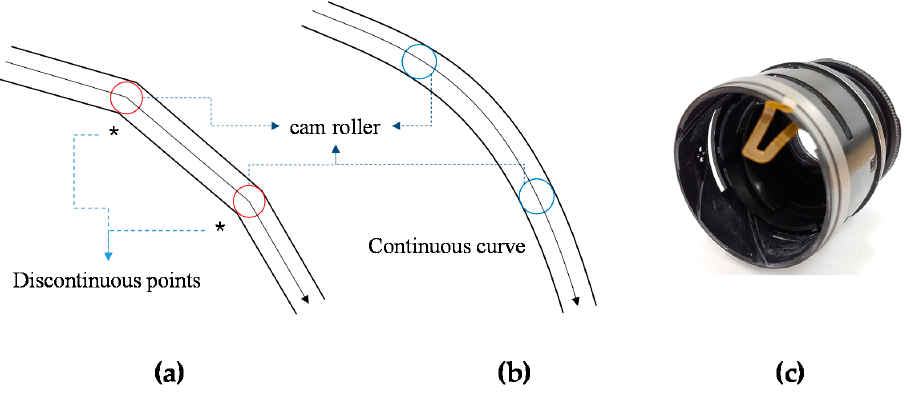
Figure 1. ( a ) Linear interpolation, ( b ) curved interpolation, and ( c ) barrel for cam [8] .